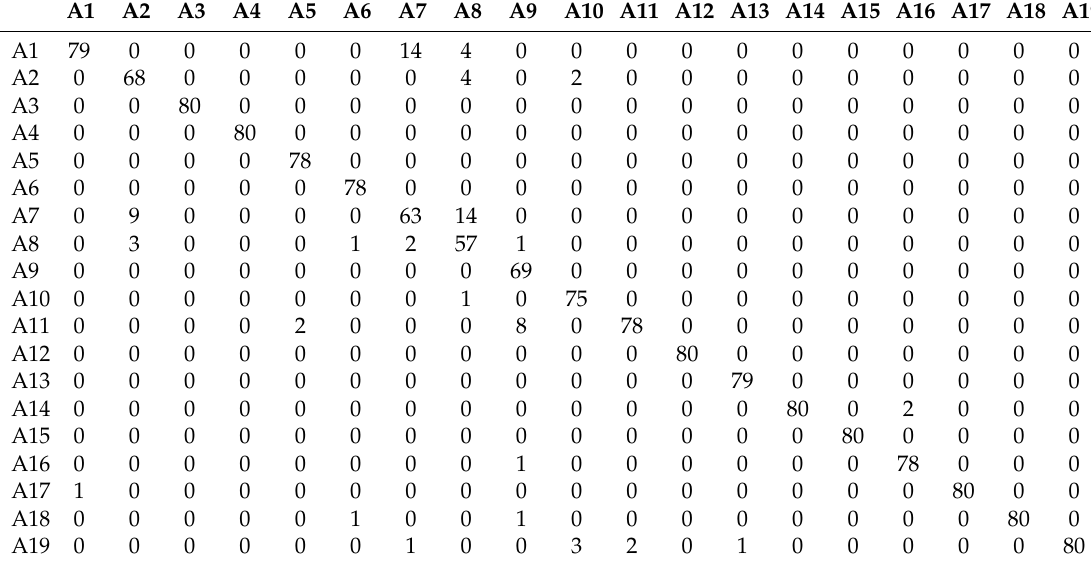
Table 3. Confusion matrix of